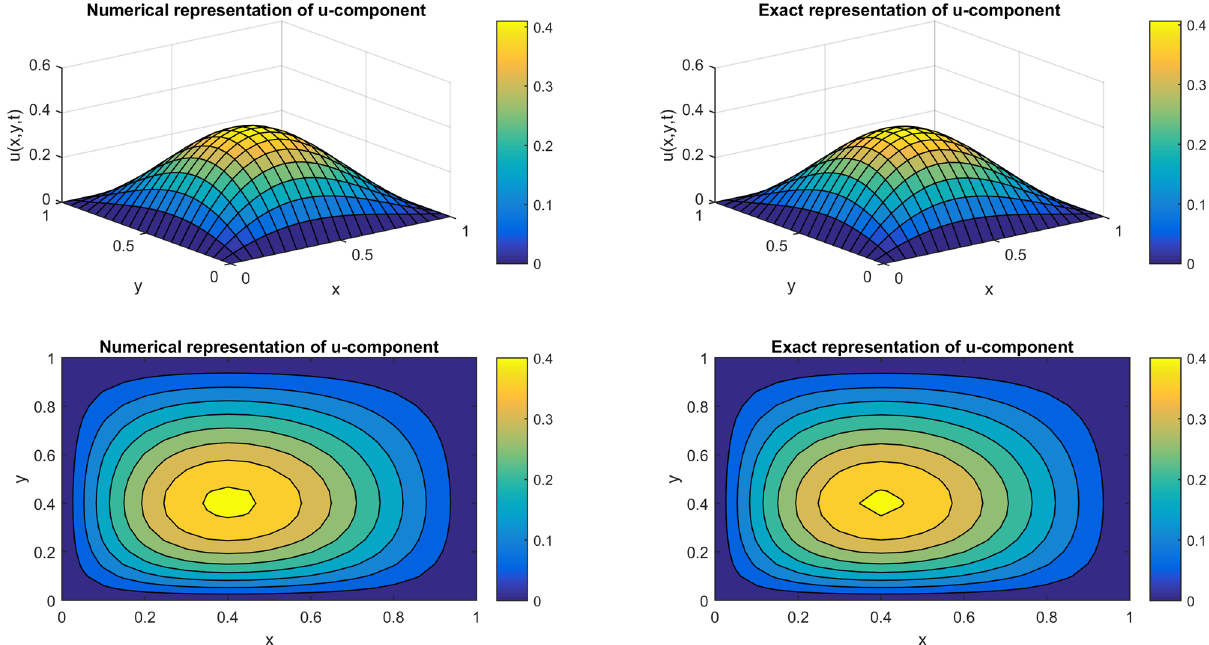
Figure 19: Surface and contour plots for u component at = t 1 for = N 21 , = α 1 , = β 1 , = t Δ 0.0001 , and = τ 0.5 using Method I regarding Example 10.